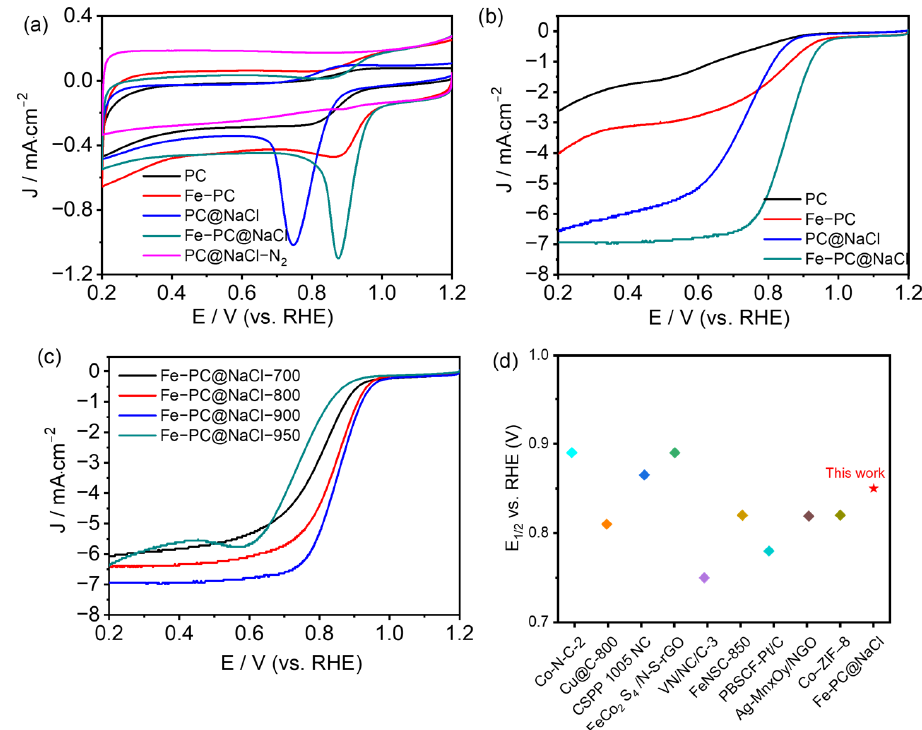
Figure 6. ( a ) CV curves of PC, Fe-PC, PC@NaCl, Fe-PC@NaCl in O 2, and PC@NaCl in N 2 -saturated 0.1 M KOH solution, respectively. ( b ) LSV curves of PC, Fe-PC, PC@NaCl, and Fe-PC@NaCl in O 2 -saturated 0.1 M KOH solution. ( c ) LSV curves of Fe-PC@NaCl-700,800,900,950 in O 2 -saturated 0.1 M KOH solution. ( d ) Comparison of half-wave potentials with the recent literature.